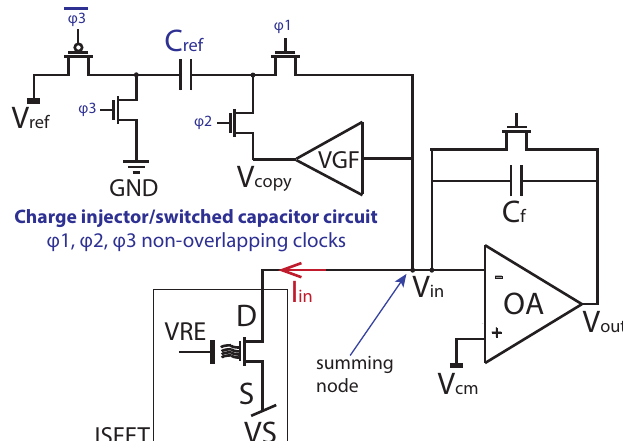
Figure 3. Integrator and switched capacitor circuit. The summing node of the currents is the V in node. Analog multiplexers connect each ISFET to the front-end.